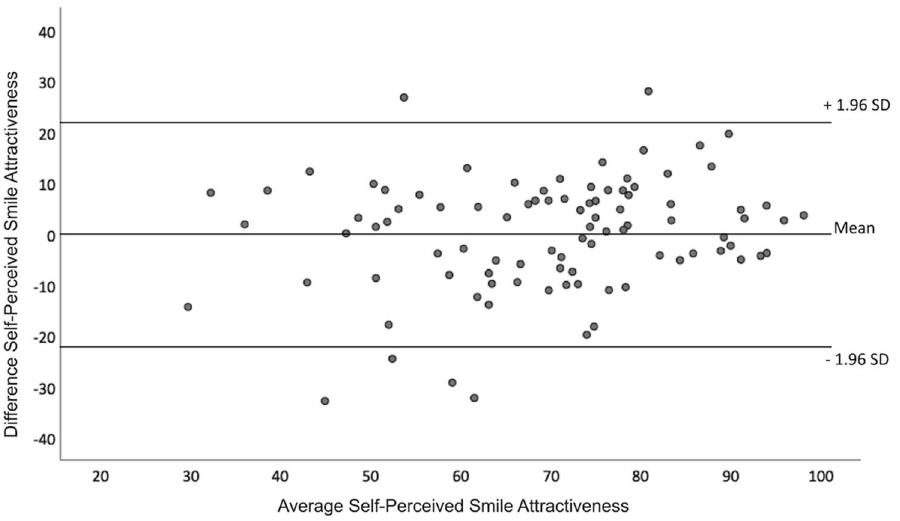
Figure 2. Bland–Altman plot showing the level of agreement in self-perceived facial attractiveness between the first and second visits of 93 subjects. (Graph was created using SPSS version 26.0, https ://www.ibm.com/produ cts/spss-stati stics